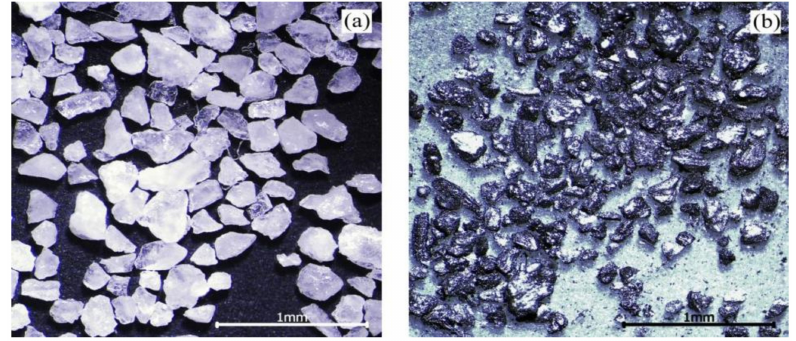
Figure 3. Morphology of the abrasives: ( a ) quartz sand; ( b ) cleaned coal